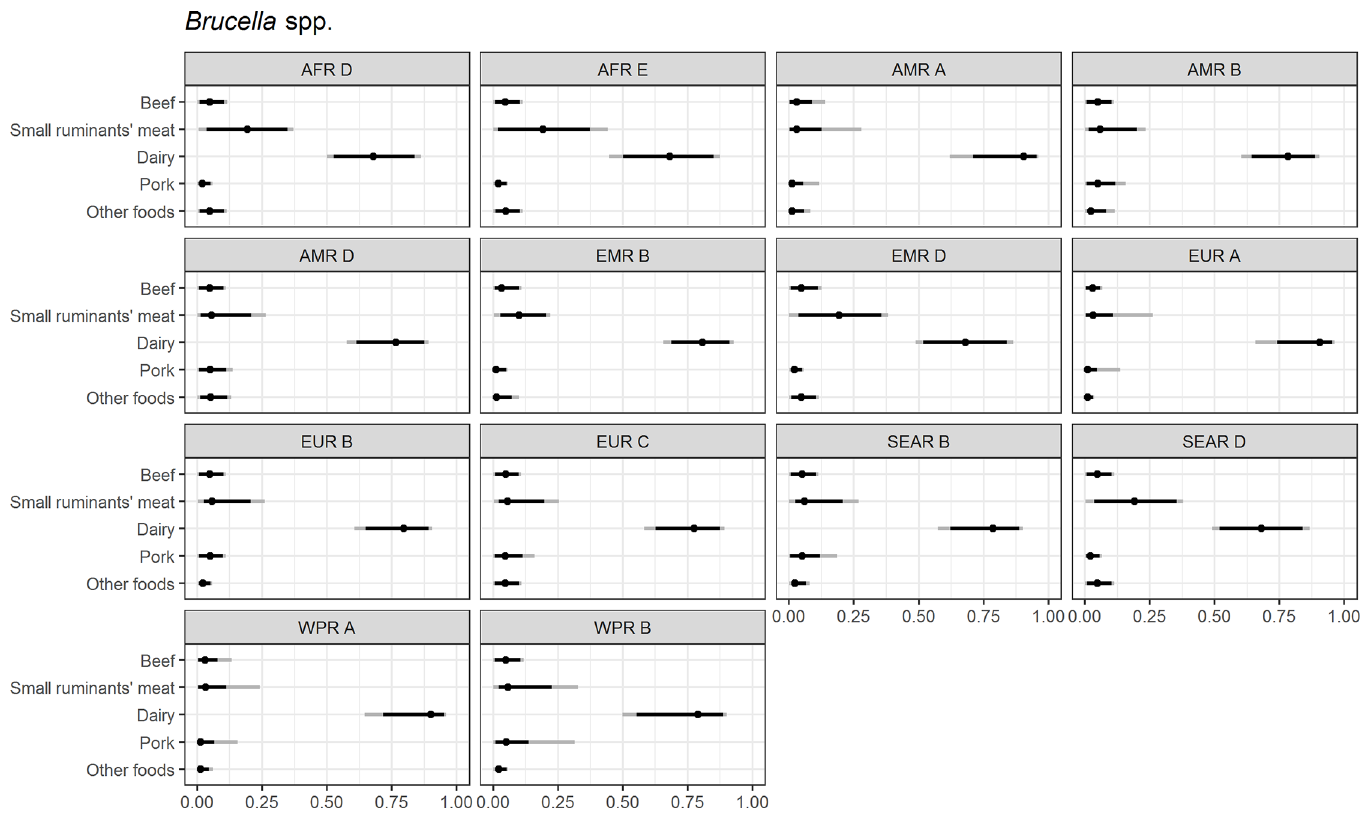
Fig 11. Brucella spp. Proportion of foodborne disease attributable to specific foods: Median estimate, and 90% and 95% uncertainty intervals by bacteria and subregion. “Small ruminants’ meat” was listed as “Goat, lamb and other small ruminants’ meat” in the expert elicitationinstrument. The X-axis labels are percentages. The dot representsthe median estimate; the dark black line, the 90% uncertainty interval; and the gray line the 95% uncertainty interval.